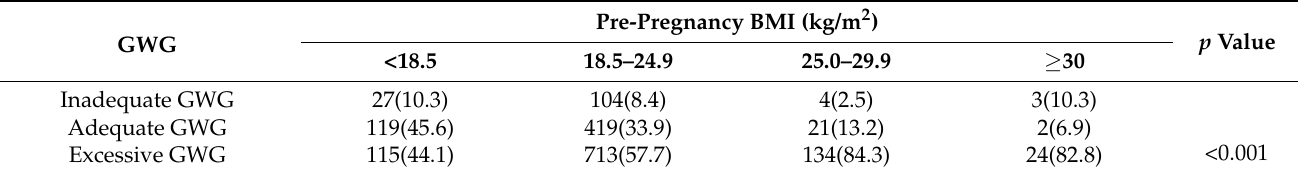
Table 2. Association between pre-pregnancy BMI and GWG [ n